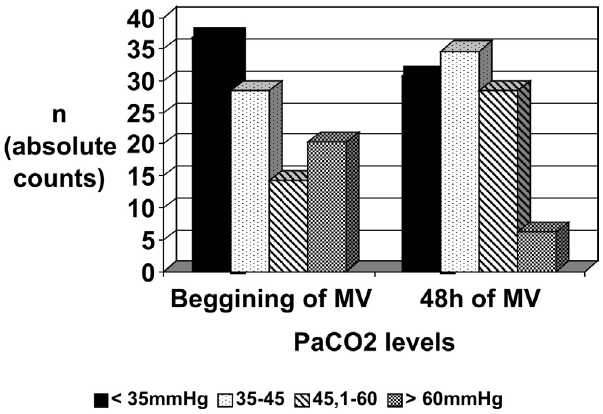
Figure 2 - PaCO levels of children submitted for 24 hours of MV or more 2 in a reference Brazilian PICU, admitted from October 01 st , 2005 to March 31 st ,